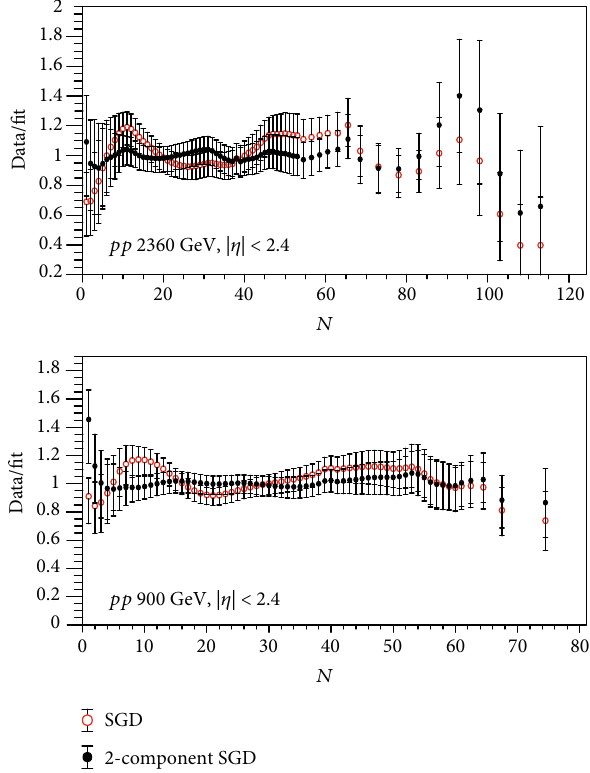
ð N Þ / P ð N Þ for the pp data shown in Figure 4: Ratio R = P data SGD Figure 1 (red circles) and of the corrected ratio R = P ð N Þ (black P 2 ‐ componentSGD